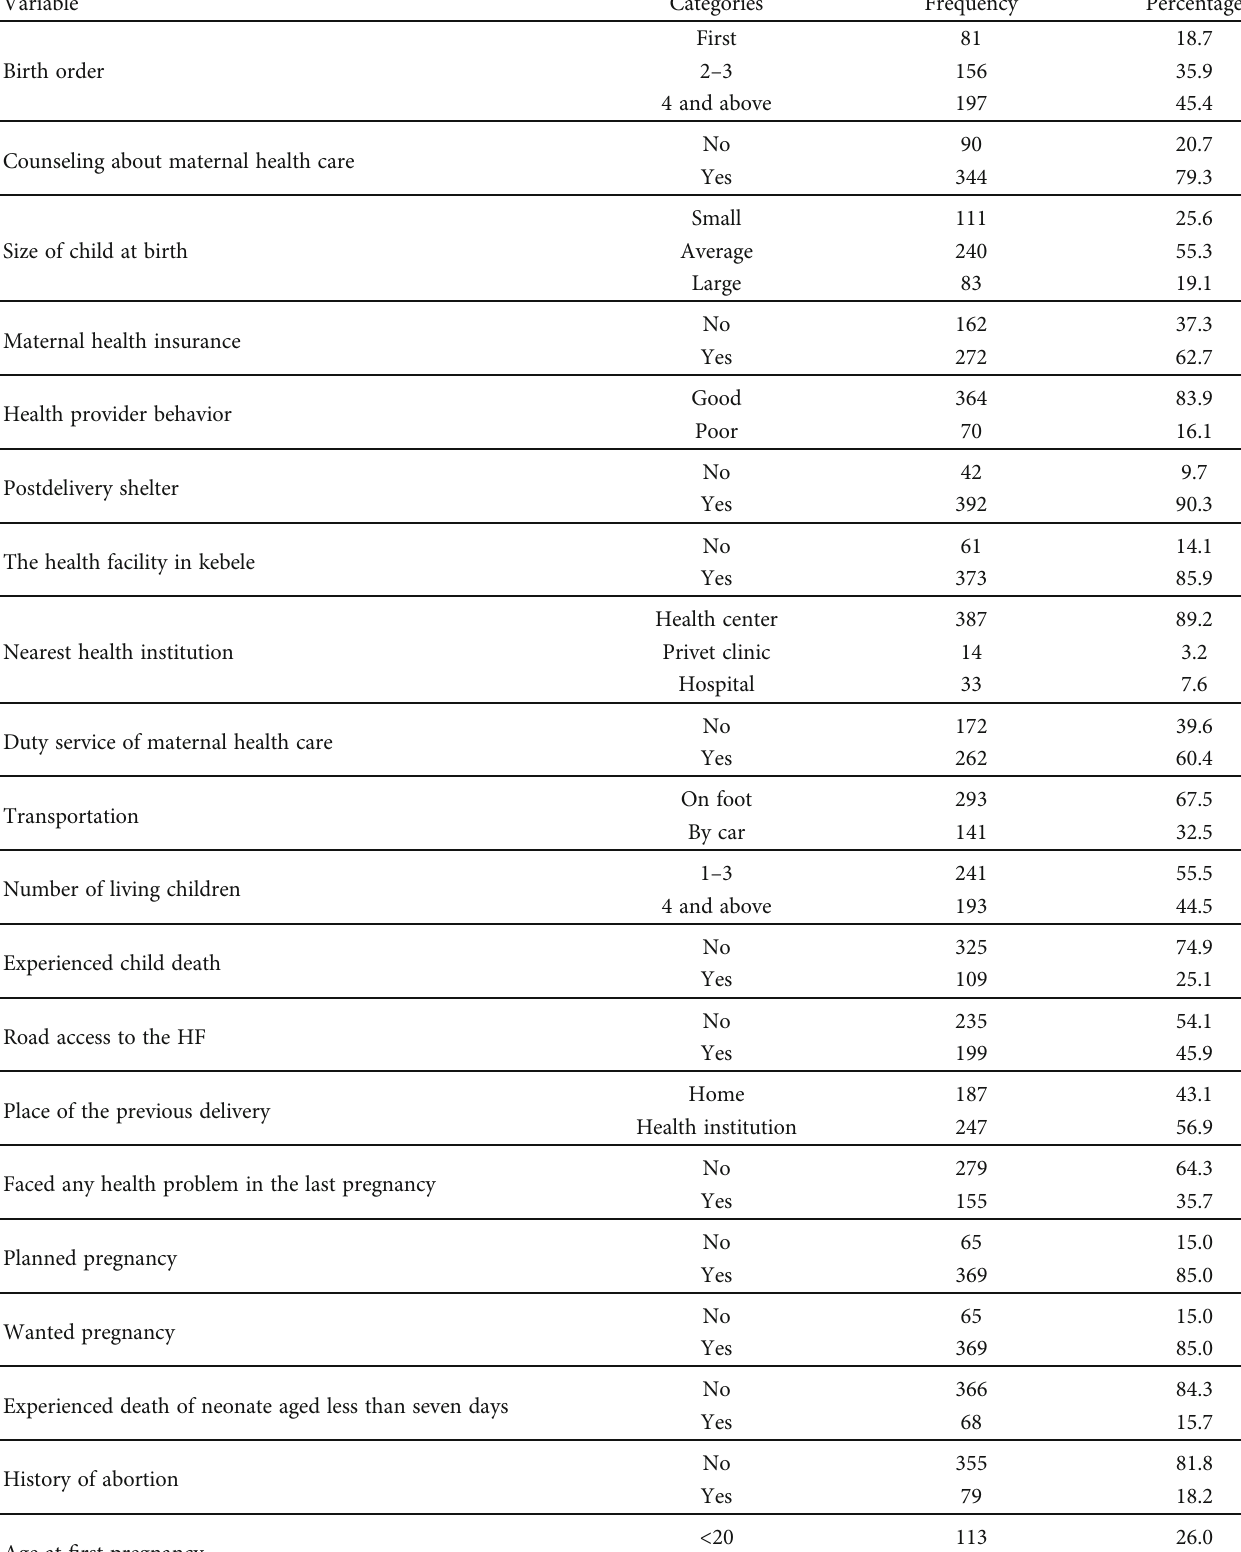
Table 2: Obstetric characteristics of respondents in the South Gondar